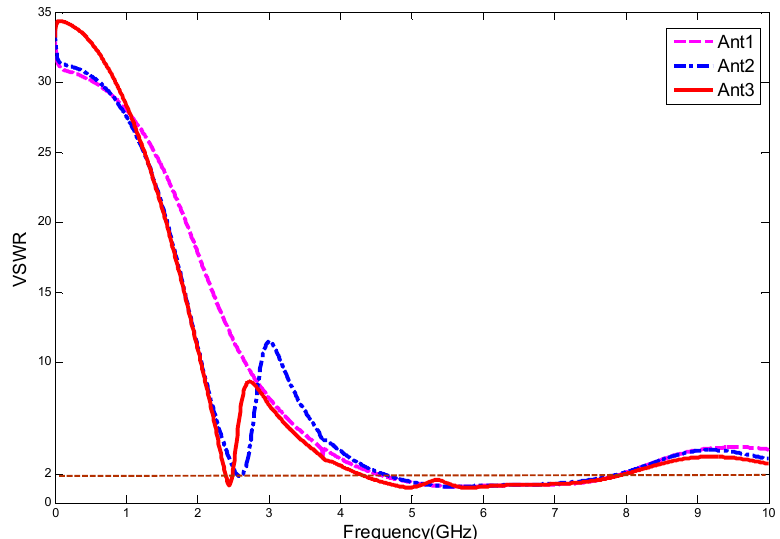
Figure 5. Simulated VSWR (voltage standing wave ratio) versus frequency for Ant1, Ant2, and Ant3 (the proposed antenna).